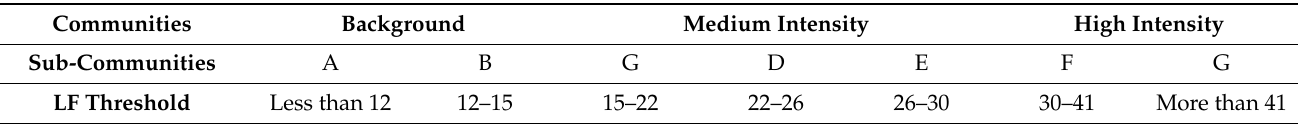
Figure 9. Concentration – area (C – A) fractal diagram of faults in the Sahlabad area. The trend change is indicated by colored lines, and each sub-community is marked with the letters A to G, respectively. Table 2. Range of lineament factor values obtained from the concentration–area (C–A) fractal model of faults in the Sahlabad area.